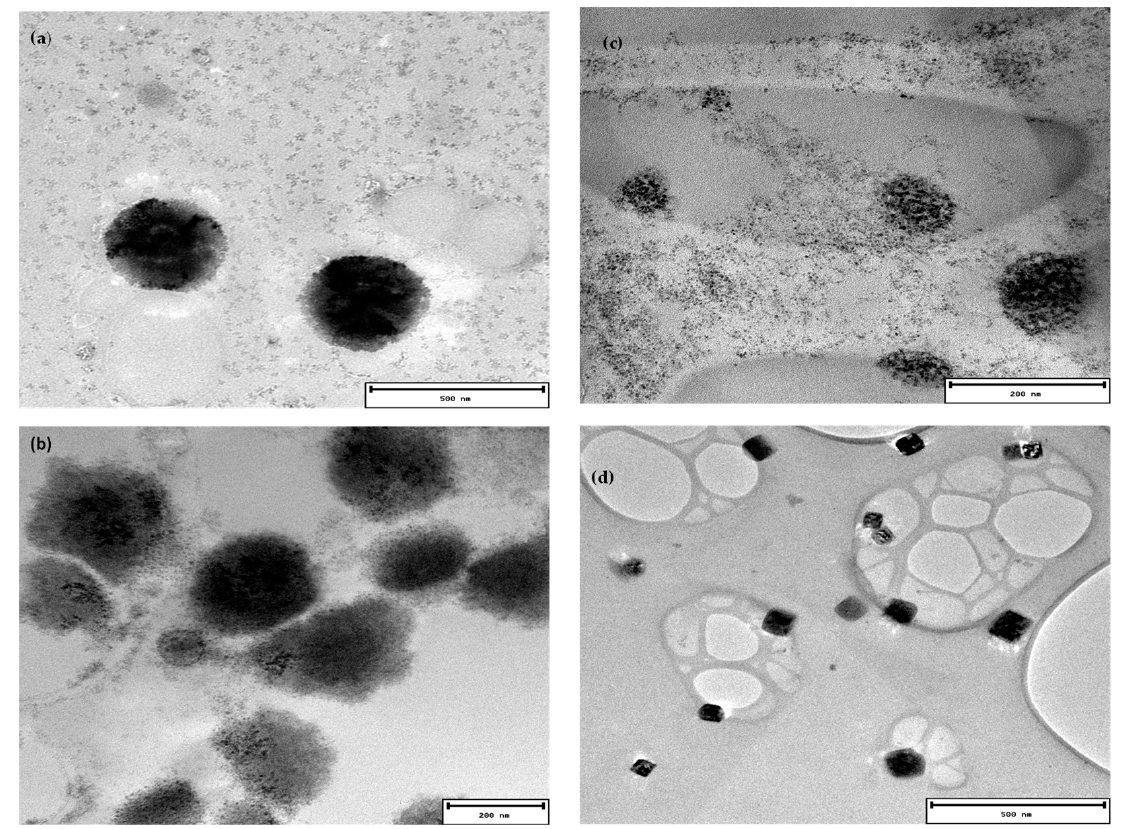
Figure 4. TEM images of lyophilized ( a ) blank Span 80 ® transferosomes; ( b ) CysA-loaded Span 80 ® ; ( c ) blank Tween 80 ® transferosomes; and ( d ) un-lyophilized Tween 80 ® transferosomes. The scale bars for ( a , d ) are 500 nm, while those for ( b , c ) are 200 nm.